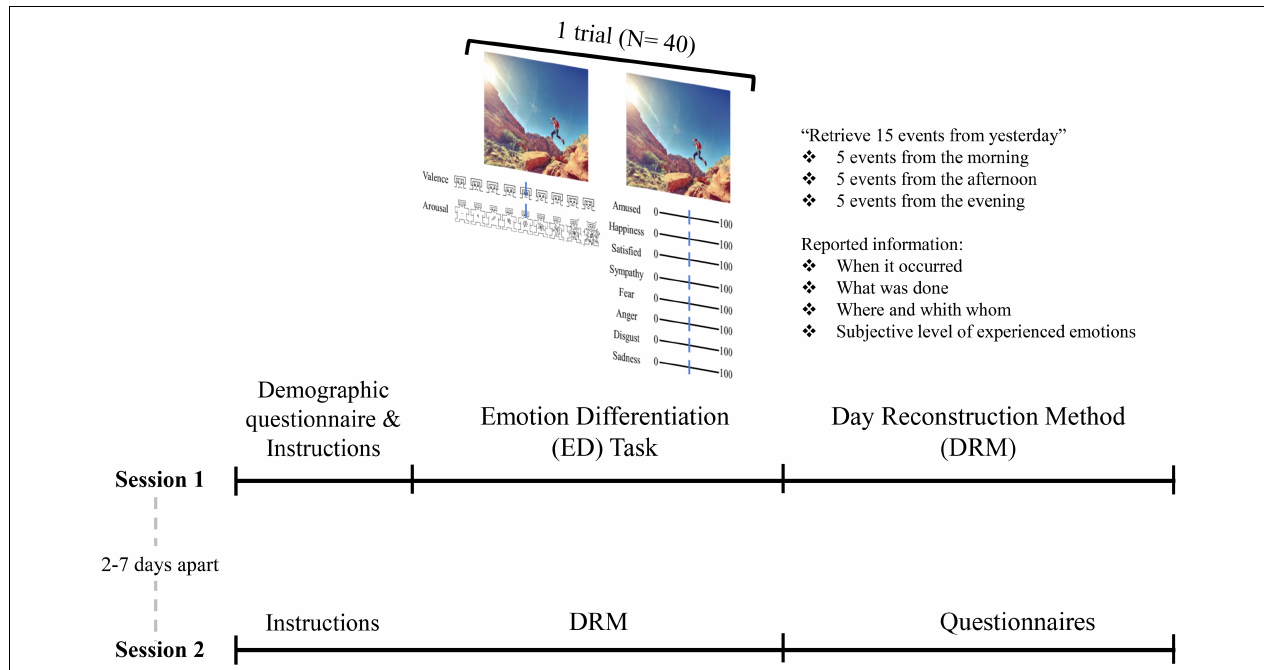
FIGURE 1 | Visual representation of the procedure. In the first of the two-session study, participants performed the Emotion Differentiation (ED) task (if they chose to) and the first part of the Day Reconstruction Method (DRM). In session 2, which took place 2 to 7 days after session 1, participants completed the second part of the DRM and the questionnaires. Picture source: